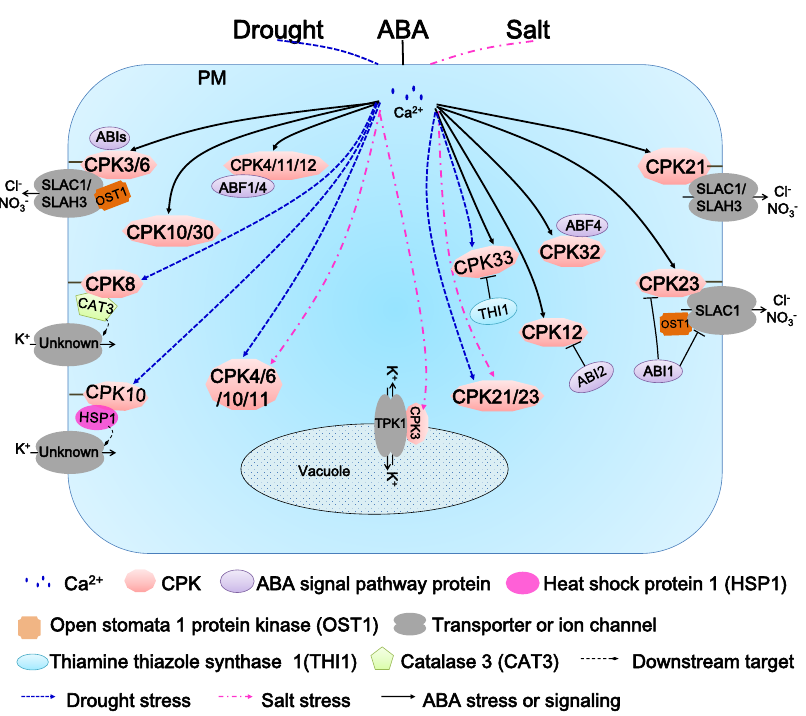
Figure 5. Function of AtCDPKs in abiotic stress responses and abscisic acid (ABA) signaling transduction.